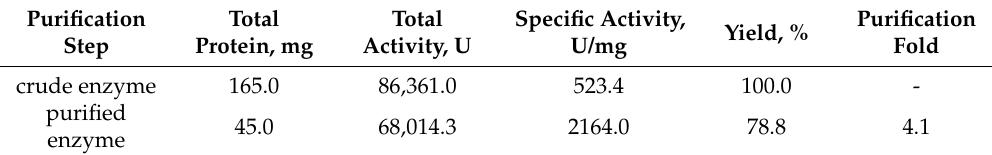
Table 1. Purification yield of recombinant L-asparaginase from T. sibiricus (TsA).